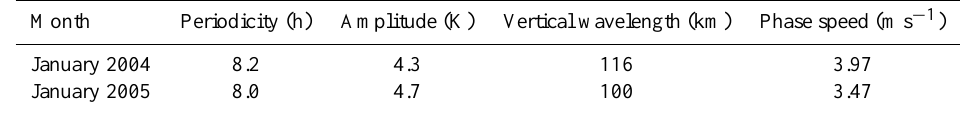
Table 3. Characteristics of the terdiurnal oscillation observed during January 2004 and January